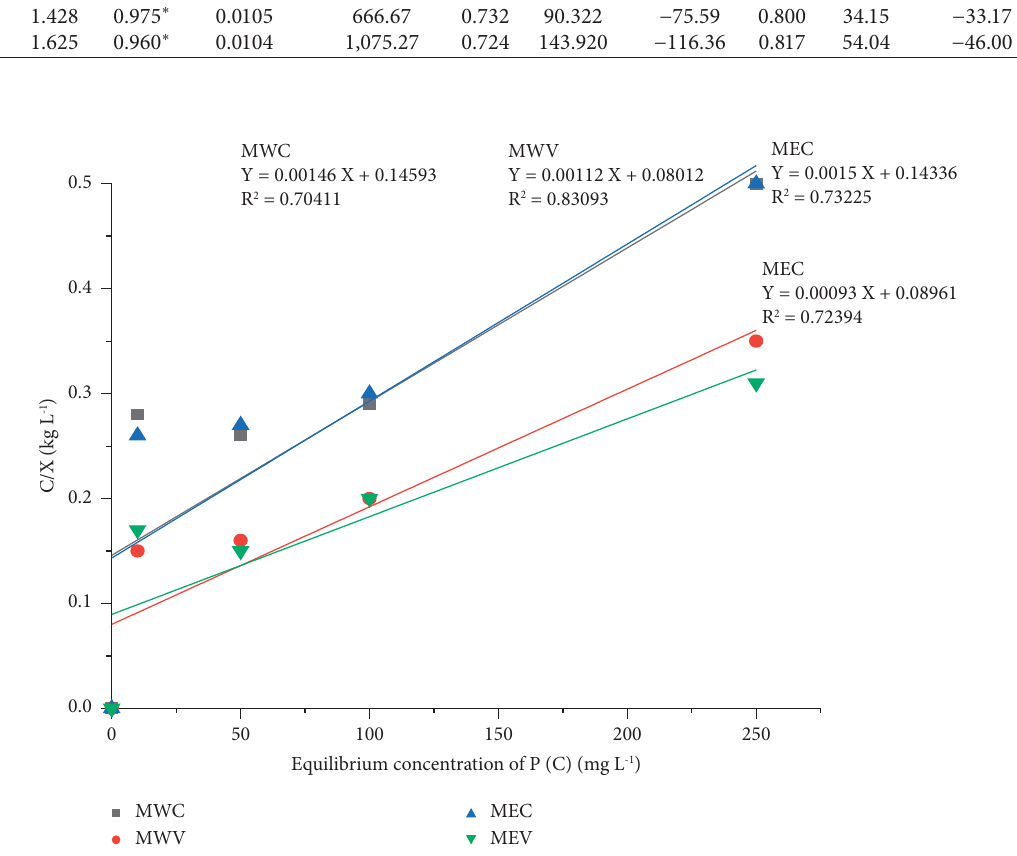
Figure 3: Linear Langmuir isotherm for the soils of Meupi (24hours equilibration at 25 ° C).